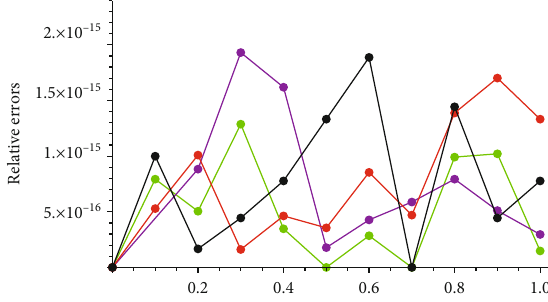
Figure 22: Absolute errors of u 2 obtained by the present method for Example 3.